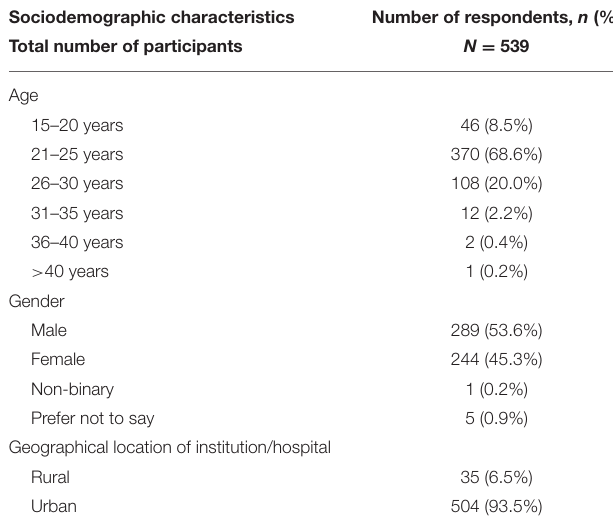
TABLE 1 | Sociodemographic characteristics of surveyed African medical